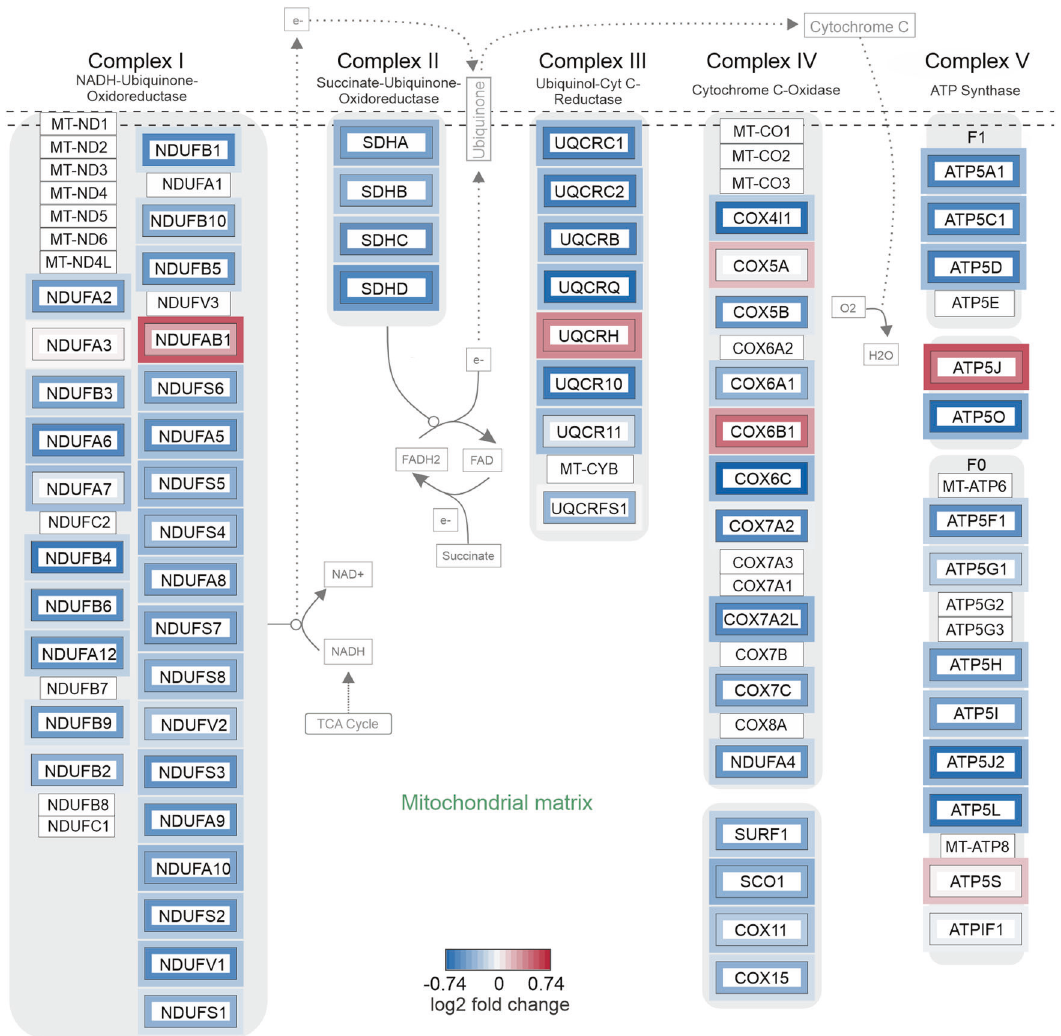
Fig. 6 Functional enrichment analysis of proteins involved in the mitochondrial electron transport chain. Proteins were colored according to the log2 fold change induced by ba fi lomycin A1 (inner frame) or torin2 (outer